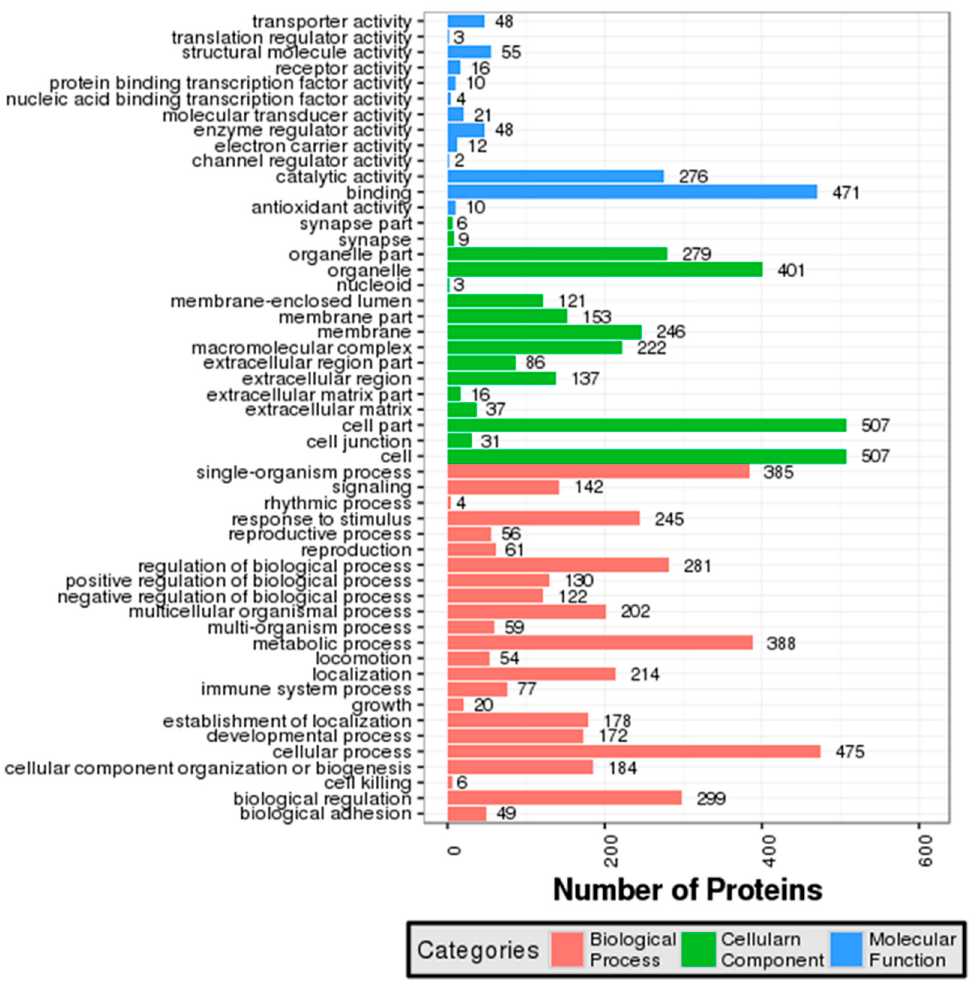
Figure 2. The Gene Ontology analysis of all identified proteins. The bar chart shows the distribu- tion of corresponding GO terms. Different colors stand for different GO terms, and the length rep- resents the GO term’s number of all proteins.